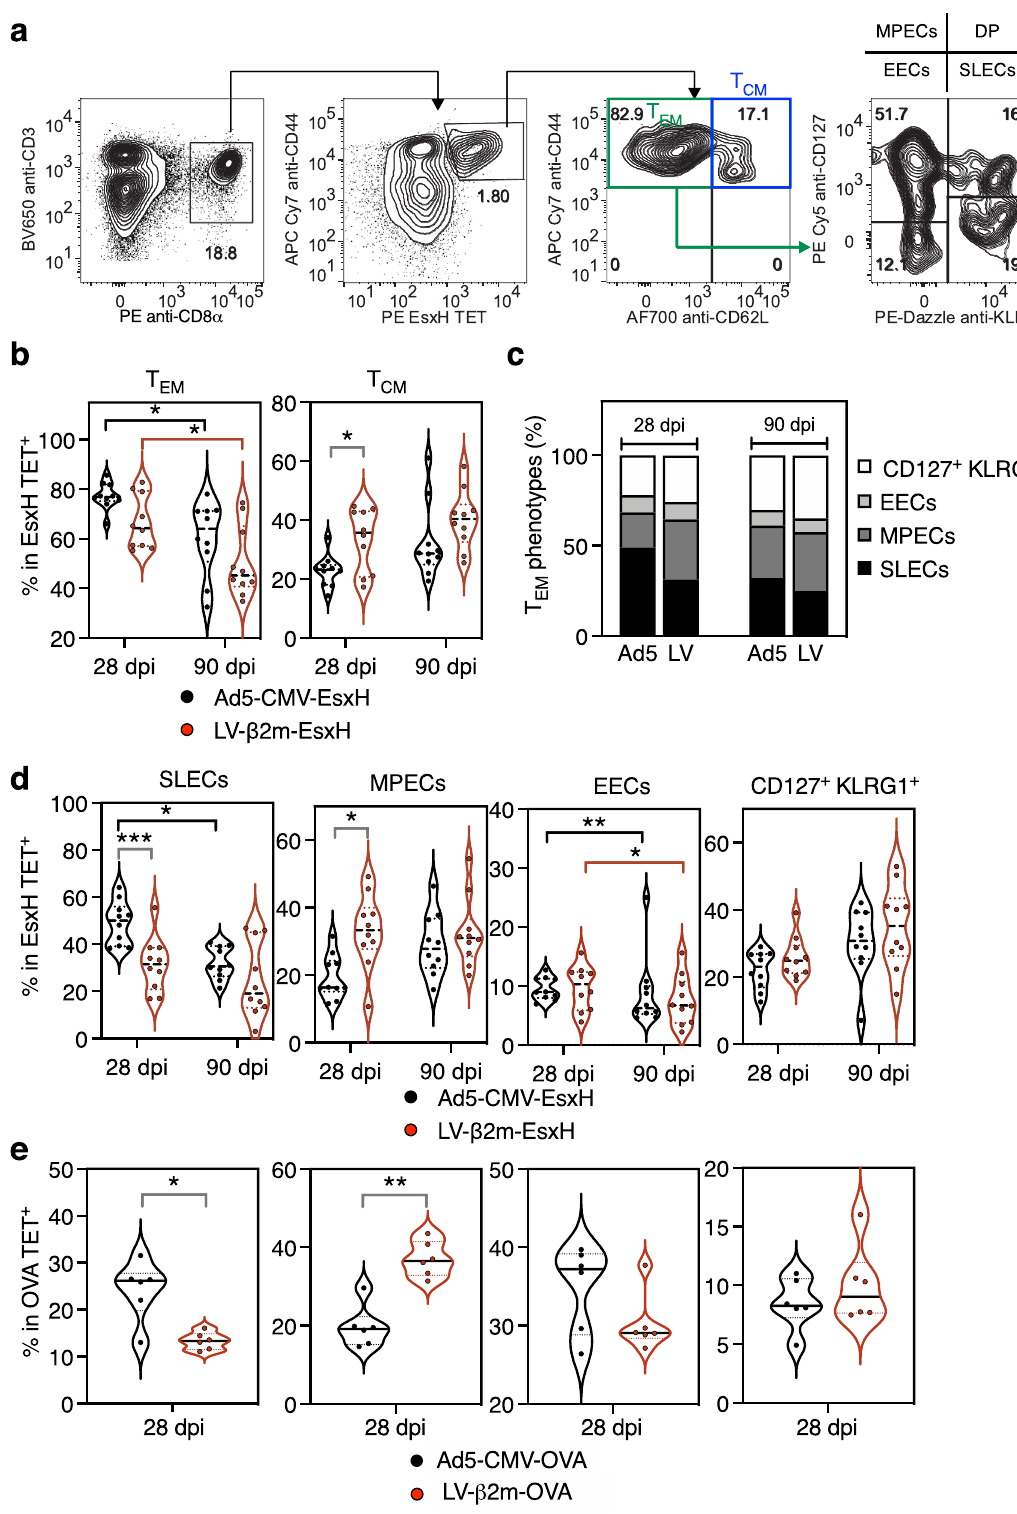
irreversible T-cell dysfunction 55,56 . In contrast, acute lymphocytic choriomeningitis virus (LCMV) and Listeria monocytogenes infection have shorter antigen availabilities and induce T cells with high CD127 expression during the effector phase 57,58 . LV- β 2m immunization, in this aspect, is rather similar to the latter case where a short burst of antigen expression can give rise to high T-cell memory frequency.